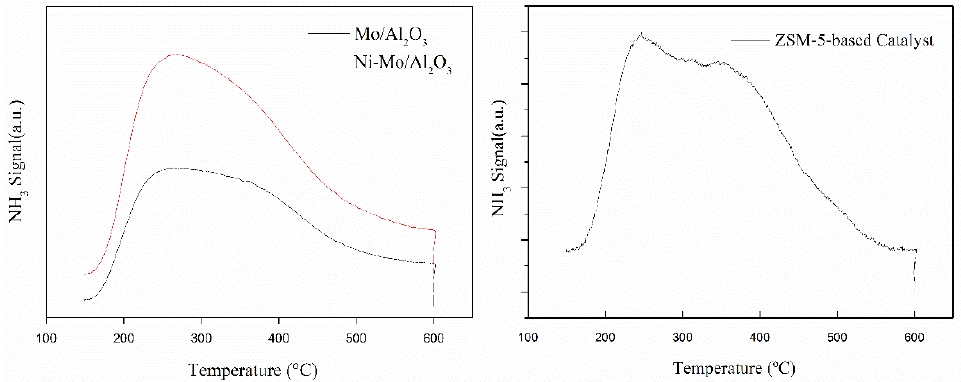
, and ZSM-5-based catalyst.